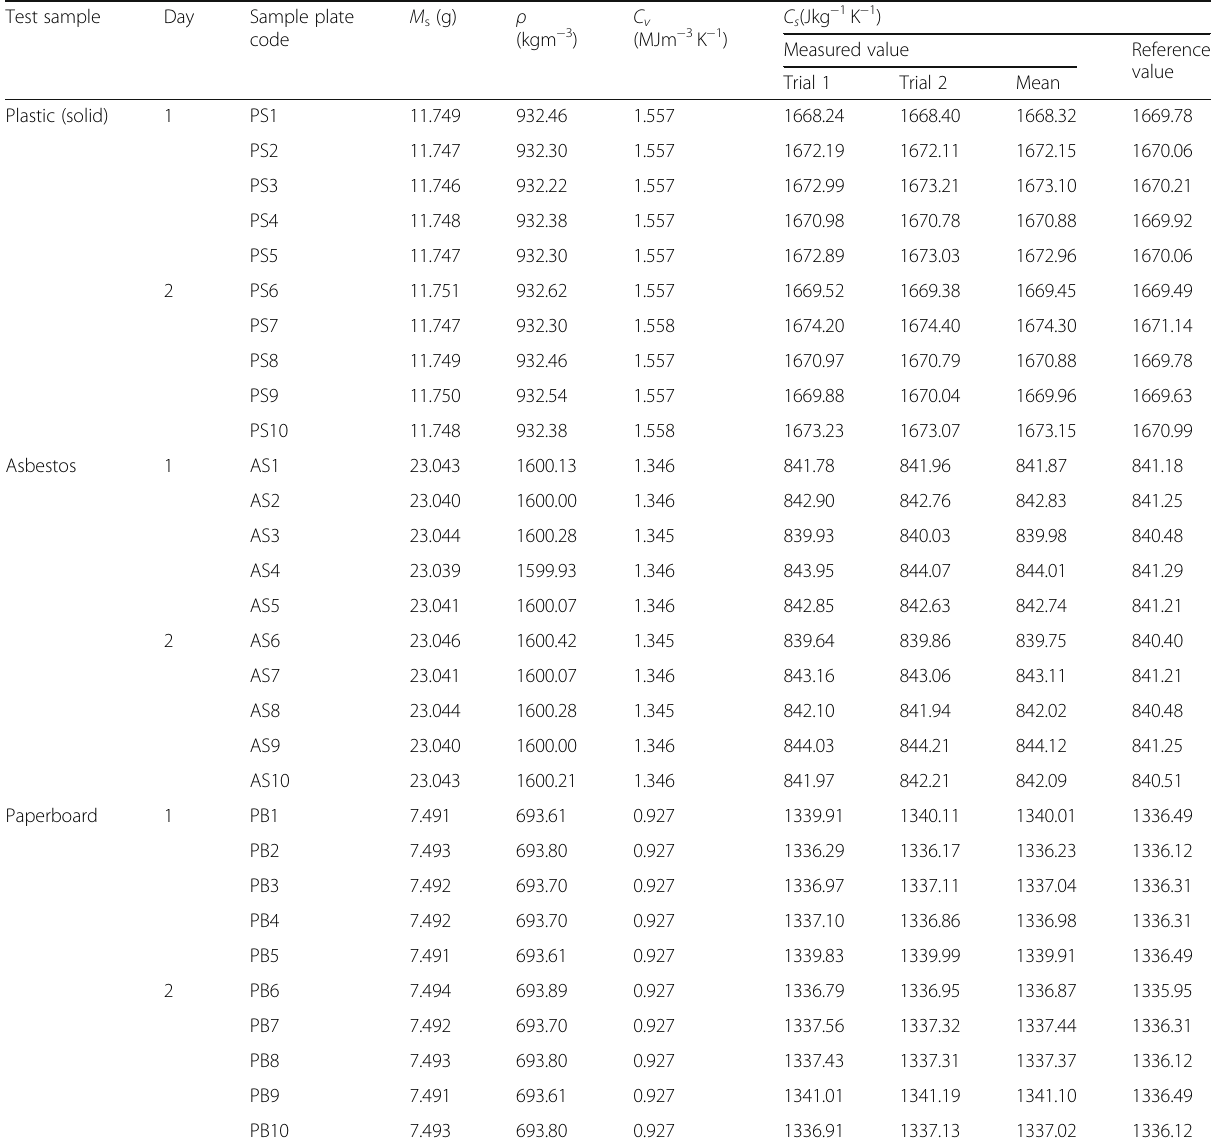
Table 1 Parameters and specific heat capacity of each test sample plate Test sample